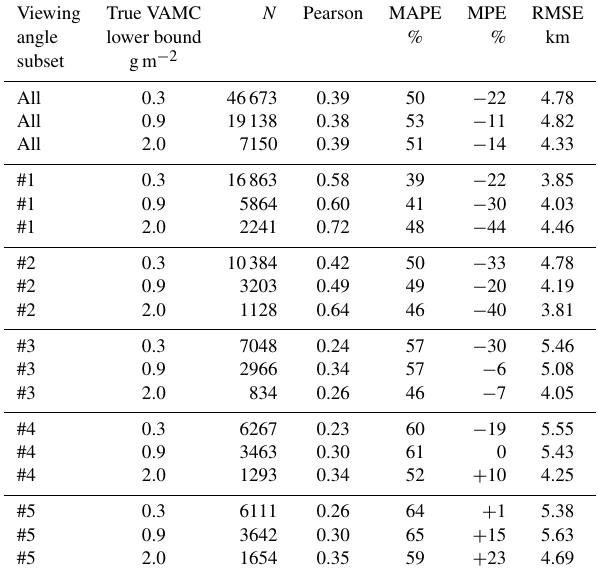
Table 3. Statistical evaluation of VATH from VADUGS against simulated observations (representing the truth) for VA with true VATH ≤